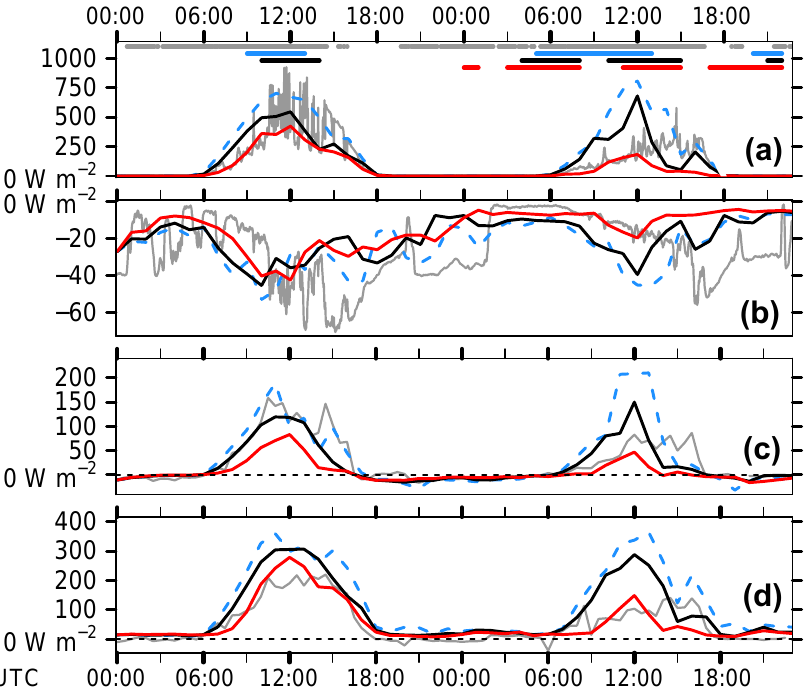
Figure B1. Comparison between Savè supersite observations (Kohler et al., 2016, gray) and COSMO-ART reference (black), clean (blue) and polluted (red) (a) net downward shortwave radiation (Wm − 2 ), (b) net downward longwave radiation (Wm − 2 ), sensible heat flux (Wm − 2 ) and latent heat flux (Wm − 2 ). The horizontal lines in (a) denote clouds over Savè in the observations and